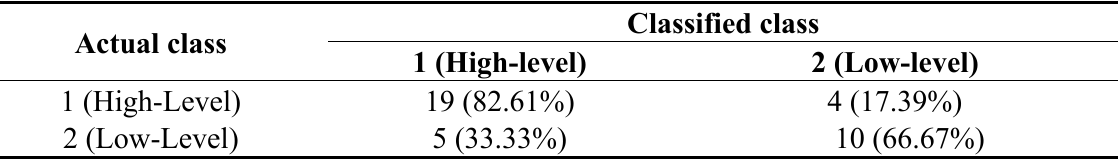
Table 10. RST-DEA-KNN model (model VII) results with both significant variables and DMU.